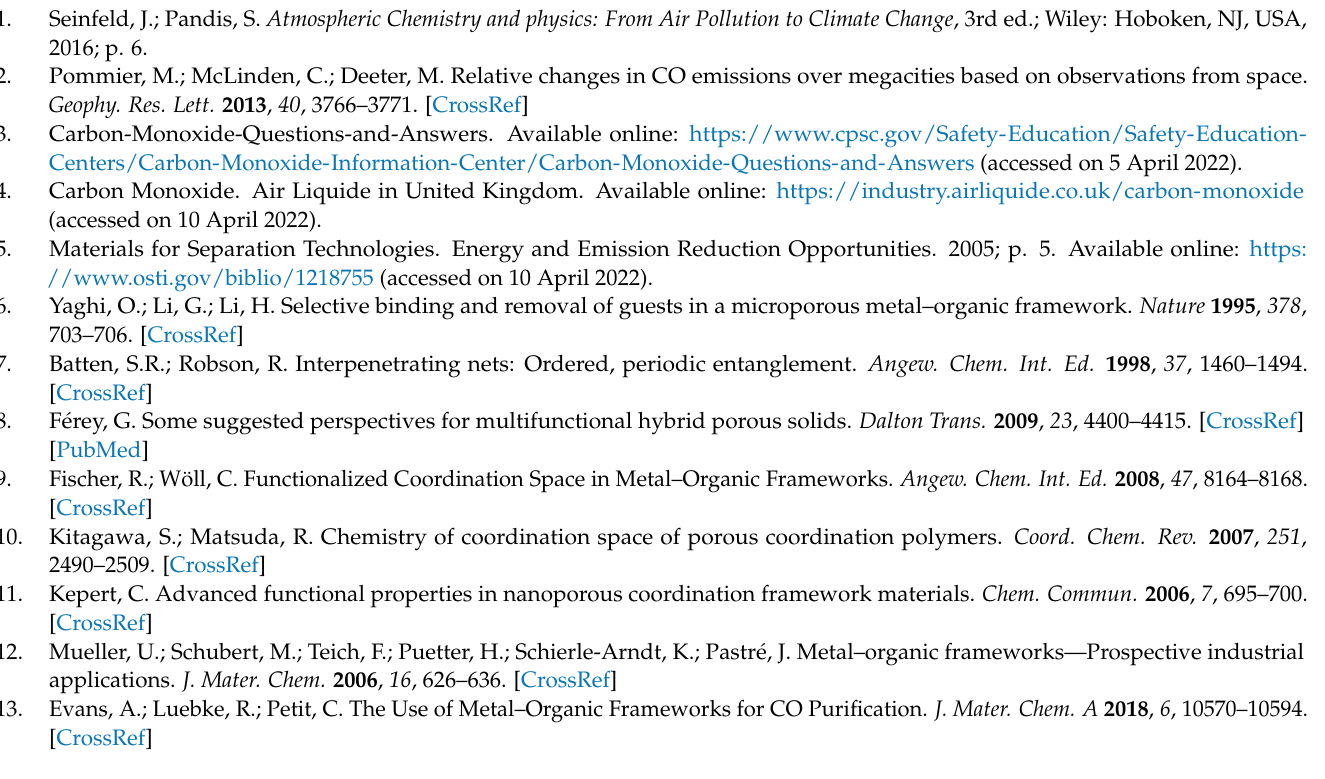
Figure S6: Fitting of the ( ε , σ ) parameters of the UFF potential on the QM data obtained from the